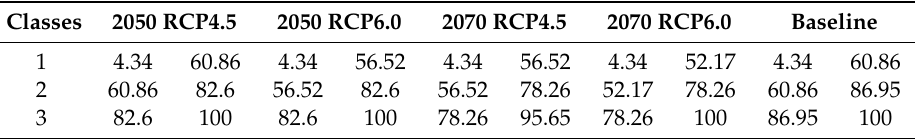
Table 1. Ranges of the di ff erent classes of